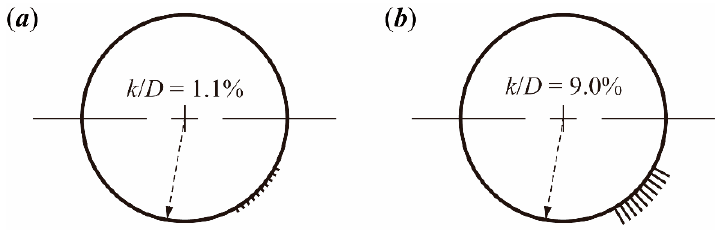
Figure 6. A schematic of overall profile of a circular cylinder with microfiber coating at a coating location of θ = 120°: ( a ) k / D = 1.1%; ( b ) k / D = 9.0%.